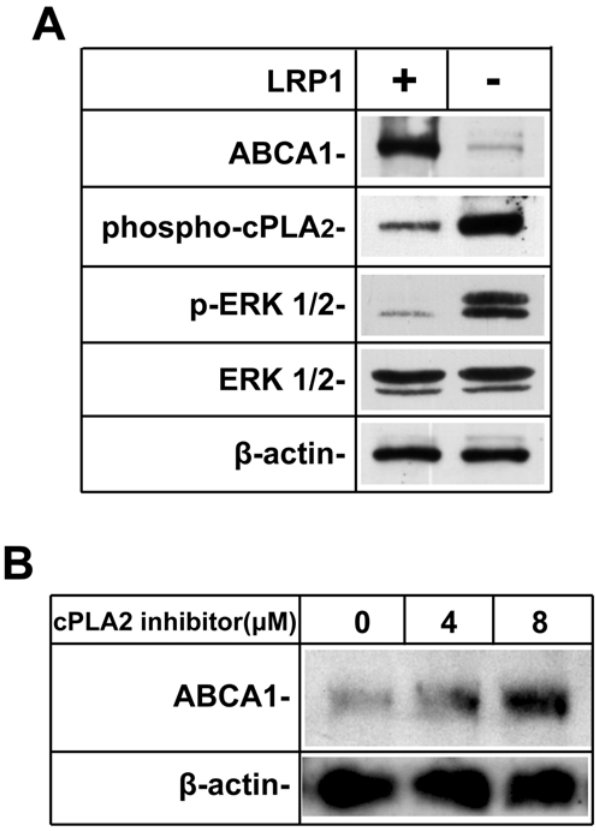
Figure 8. Phosphorylation of cPLA 2 is markedly increased in LRP1-deficient SMCs. A . Western blotting was performed to determine the phosphorylation state of cPLA 2 and ERK in the presence and absence of LRP1 in primary SMCsR A significant increase in cPLA 2 and ERK phosphorylation was detected using rabbit anti-phospho- cPLA 2 (Ser 505 ) and anti-phospho-ERK antibodies. b -actin was used as a loading control. Five independent experiments were analyzed and quantitated. ABCA1 protein expression in LRP1 2 / 2 was 0.21 6 0.07, phosphorylated cPLA 2 was increased by 2.73 6 0.35, and p-ERK1/2 was 3.37 6 0.56 compared to LRP + / + cells. B . cPLA 2 a inhibitor restores ABCA1 expression in LRP1-deficient SMCs. LRP1 2 / 2 SMCs were grown to confluence and treated with the indicated concentrations of the cPLA 2 a inhibitor (Calbiochem, Cat. No. 525143) for 24 h. Dose-dependent increases in ABCA1 protein expression after administration of the cPLA 2 a inhibitor were detected by Western blotting. b -actin was used as a loading